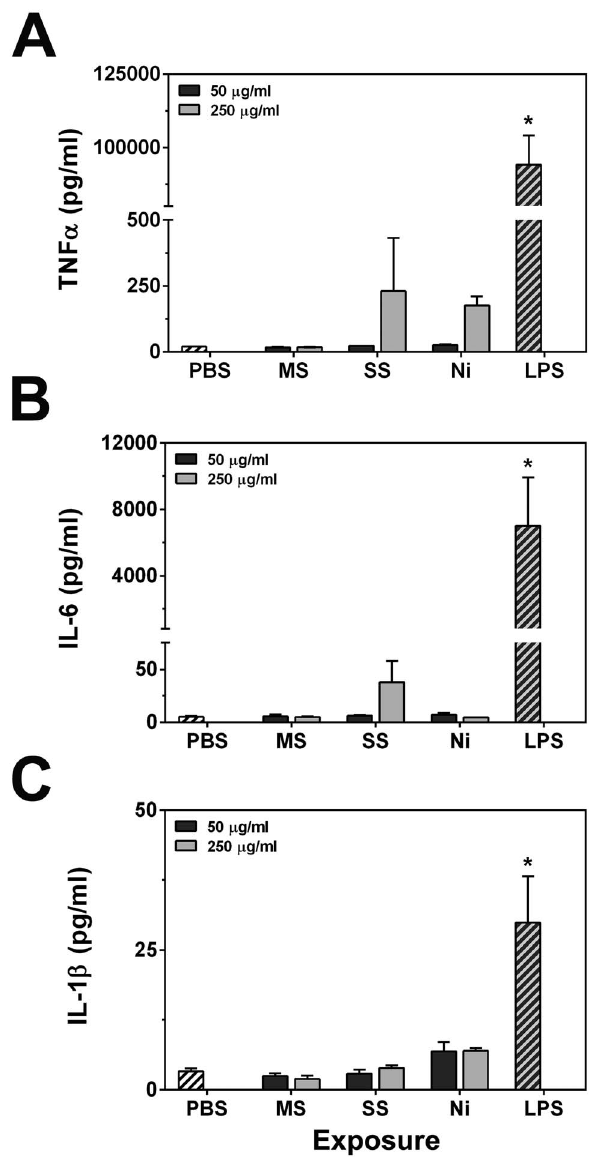
Figure 7. Welding fumes do not induce pro-inflammatory cytokine production. RAW 264.7 cells were treated with welding fume suspensions or 1 m g/ml LPS for 24 h. Media were collected, and ELISAs were run to measure levels of TNF a ( A ), IL-6 ( B ) and IL-1 b ( C ). Error bars represent the mean 6 SD (n=3). *, p , 0.05 compared to PBS controls.